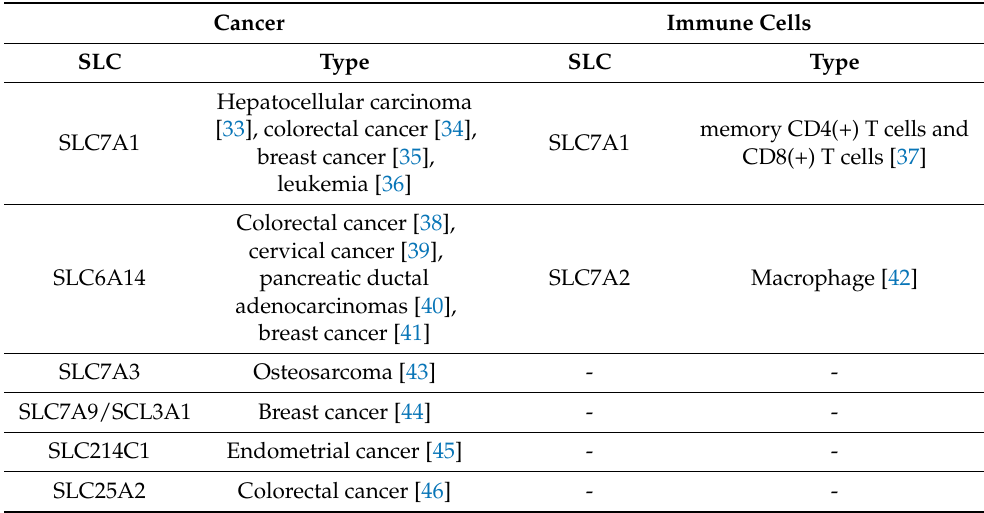
Figure 2. Arginine-related signaling pathways. Arginine can be transported by solute carriers (SLCs), including lysosomal SLC38A9, to activate the down-stream mTORC1 signaling pathway. In addition, arginine also can bind G-protein coupled receptor, GPRCA6, to activate down-stream RAS/ERK or PI3K pathway to reprogram the general. Table 1. Summary of arginine transporters (solute carriers) in cancer vs. immune